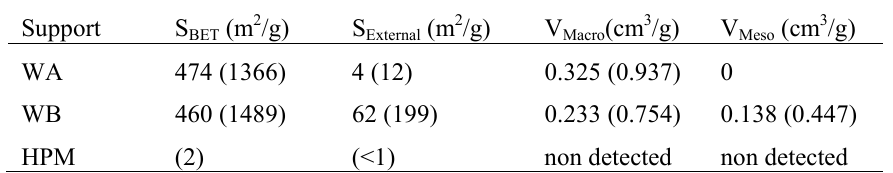
Table 6. Surface characteristics of the carbon-based HMs. Values in parenthesis are given per gram of carbon. From reference [67], with permission from